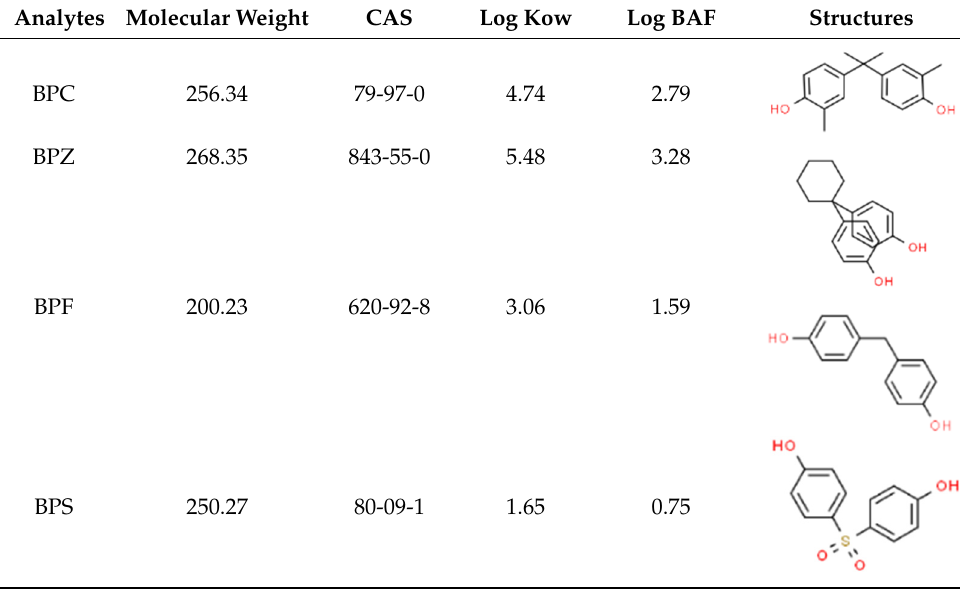
Table 1. Physicochemical properties of BPC, BPZ, BPF, and BPS.